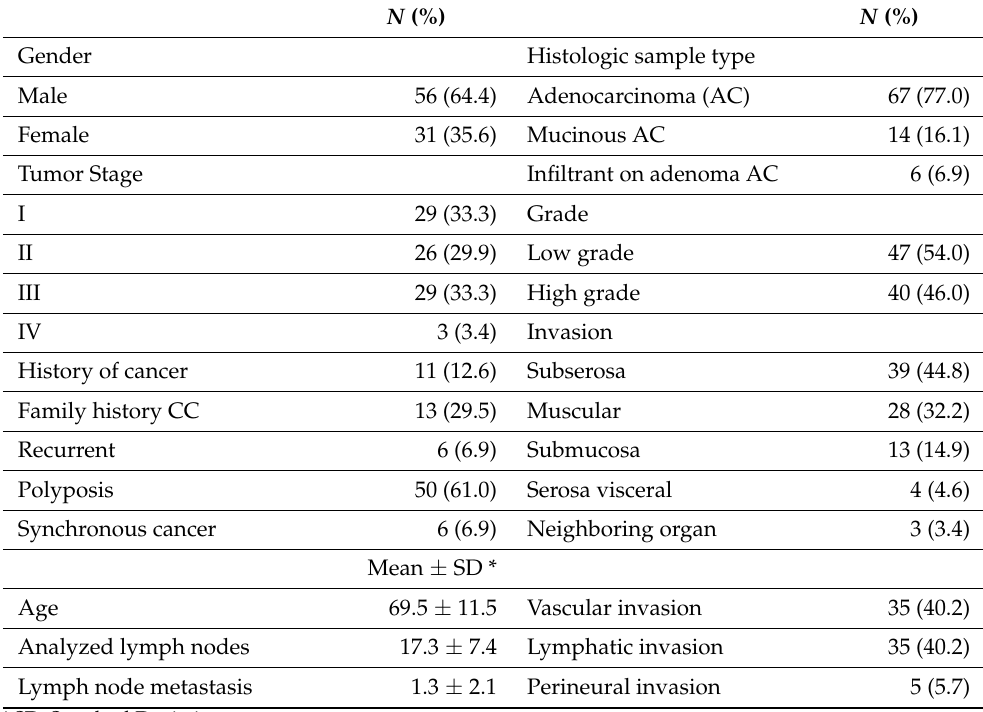
Table 1. Characteristics of patients with Colon Cancer (CC) ( N = 87).